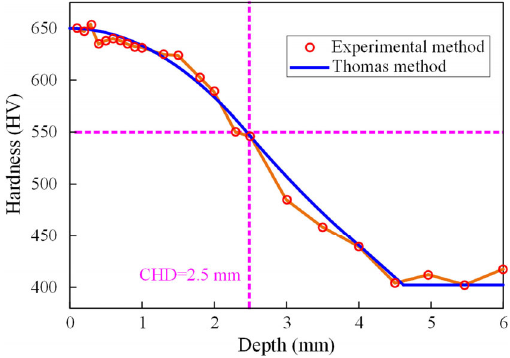
Fig. 5 Measured and empirical hardness profiles.